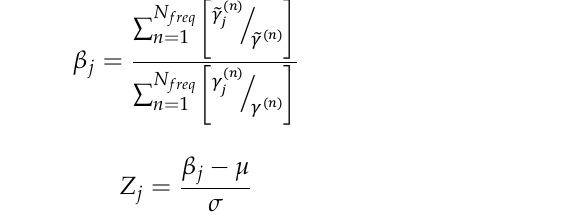
Table 2. First mode natural frequency of MSE-DI hybrid-sti ff ened models.